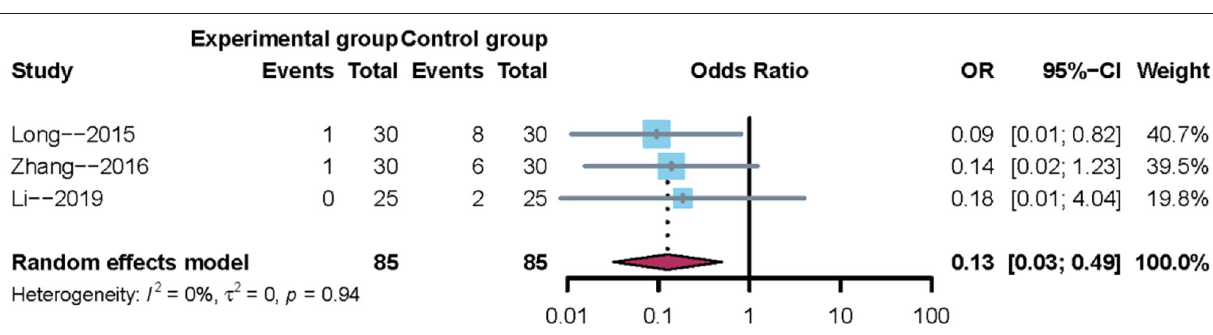
FIGURE 5 | Meta-analysis of the incidence of